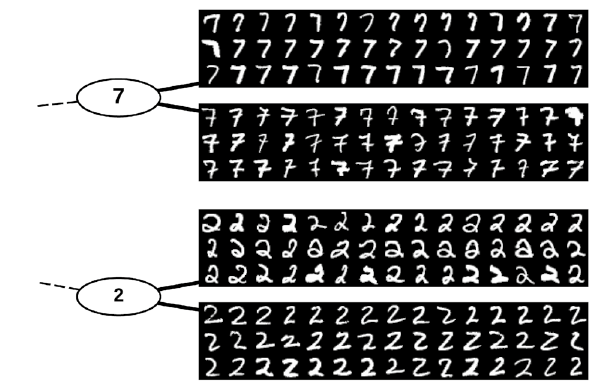
Fig. 6 The plots show two extracted sub-trees from interesting sub- populations of the MNIST dataset found by DeepECT. These are the digits seven (with and without a middle-crossbar) and two (a curly and a ‘streamlined’ version, looking more like the character ‘Z’). The shown digits are randomly